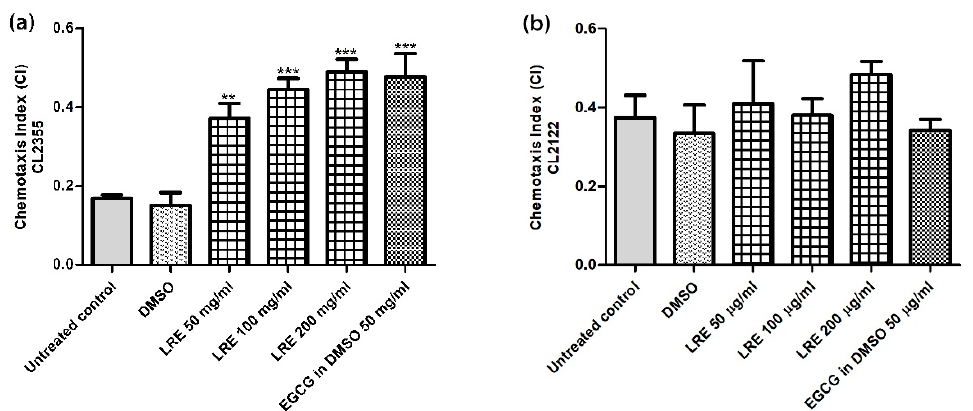
Figure 6. The effect of different concentrations of LRE extracts against A β -induced reduction of chemotaxis behavior in C. elegans . ( a ) treatment of CL2355 worms ( A β + ) with LRE and EGCG (positive control); ( b ) treatment of CL2122 worms ( A β - ) with LRE and EGCG (positive control). Values are mean ± SEM of at least three independent runs. ** p < 0.01; *** p < 0.001 vs. DMSO.